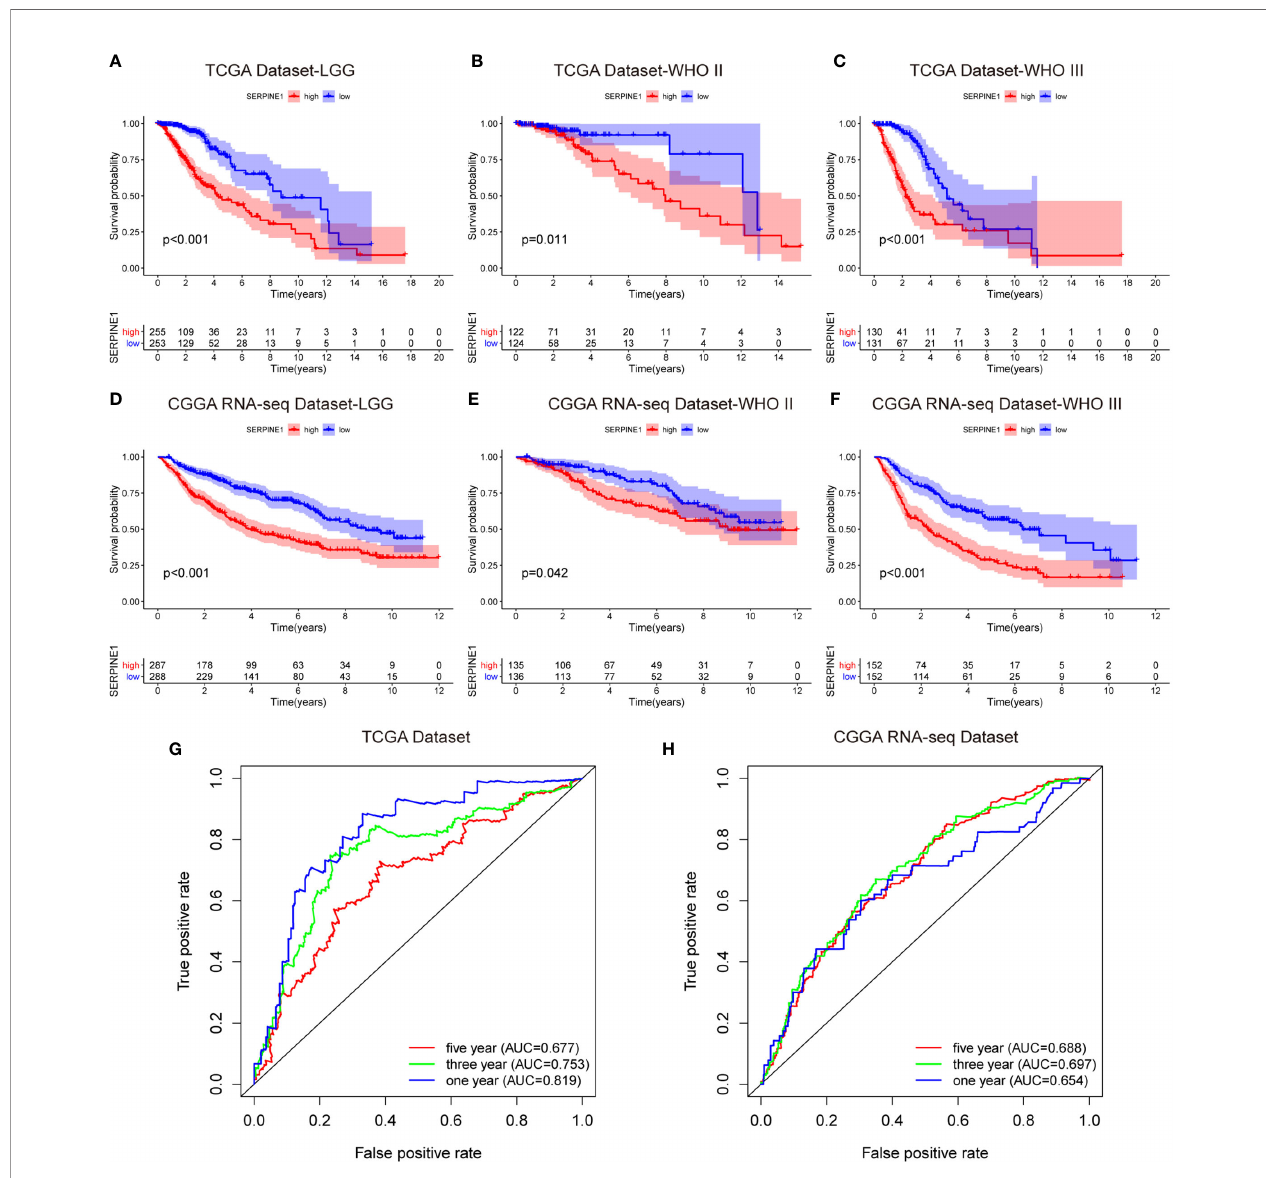
FIGURE 5 | SERPINE1 high expression predicted an unfavorable prognosis in the LGG patients. (A, D) Kaplan-Meier overall survival analysis of SERPINE1 expression in all LGG patients. (B, E) Kaplan-Meier overall survival analysis of SERPINE1 expression in patients with grade II glioma. (C, F) Kaplan-Meier overall survival analysis of SERPINE1 expression in patients with grade III glioma. (G, H) ROC curve analysis of SERPINE1 in LGG patients. P-value < 0.05 was considered statistically signi fi